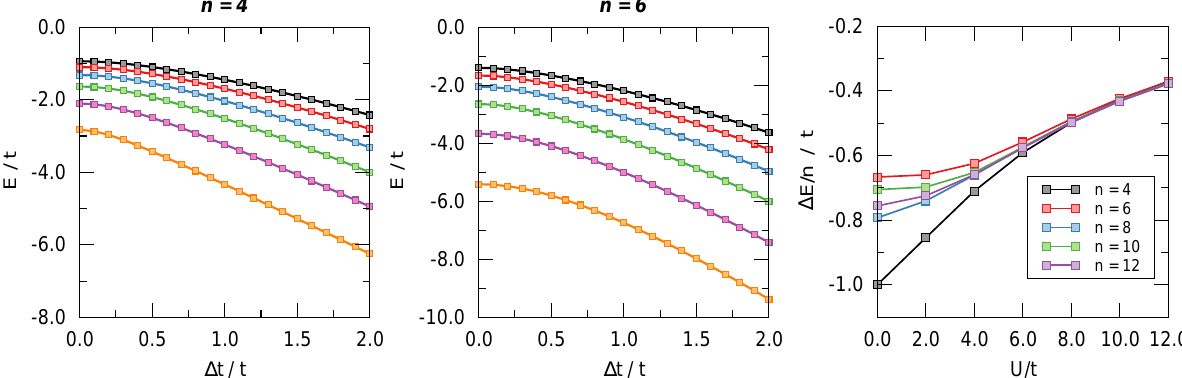
Figure 8. Left and central panel: Ground-state energy of the n = 4,6 Hubbard models for different values of U / t as functions of ∆ t / t . From bottom to top U / t = 2,4,6, . . .. Right panel: distortion energy E δ = 2 − E δ = 0 per site as a function of U / t for different number of